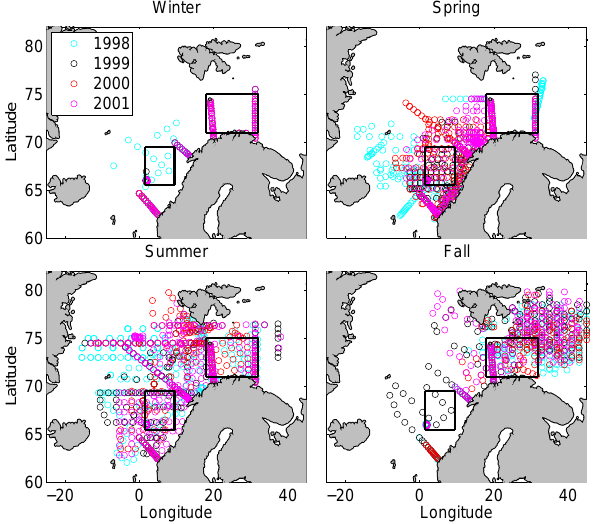
Figure 4. Spatial in situ data coverage for nitrate in different years and seasons for the data set used. The coverage for the other vari- ables is similar. The southern areas are mostly sampled in spring and summer, while the Arctic regions are more sampled in summer and fall. There are very few open-ocean measurements during win- ter, but in the sections visible in the winter-panel (upper, left) there are observations for all years and